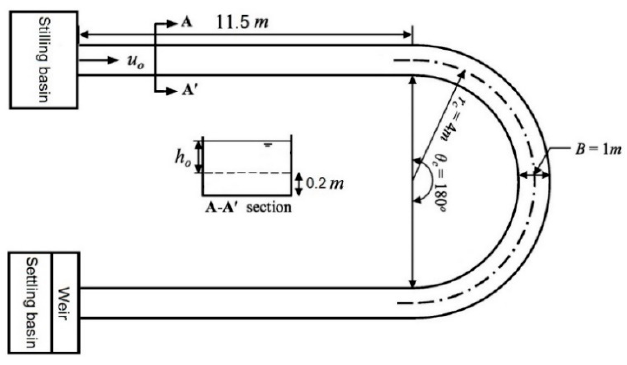
Figure 6. Bend channel geometry.